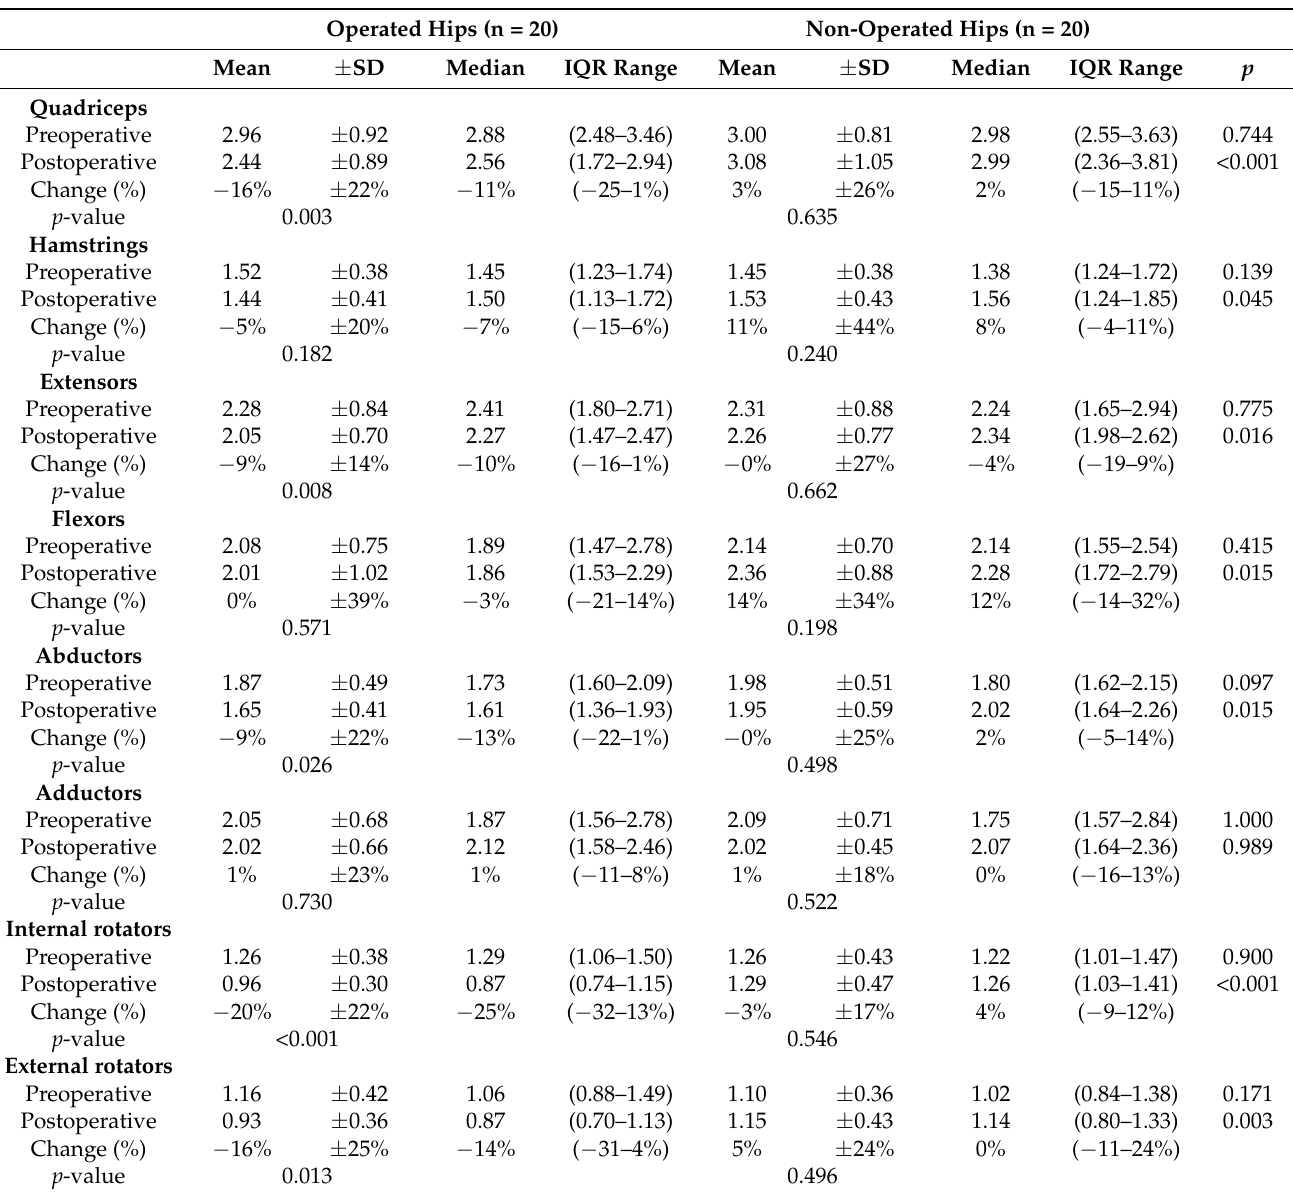
Table 2. Pre- and postoperative hip muscles strength (Nm/kg) for surgical hip